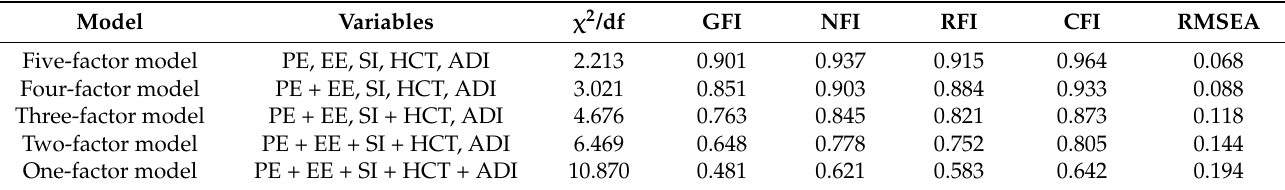
Table 4. Comparisons of measurement